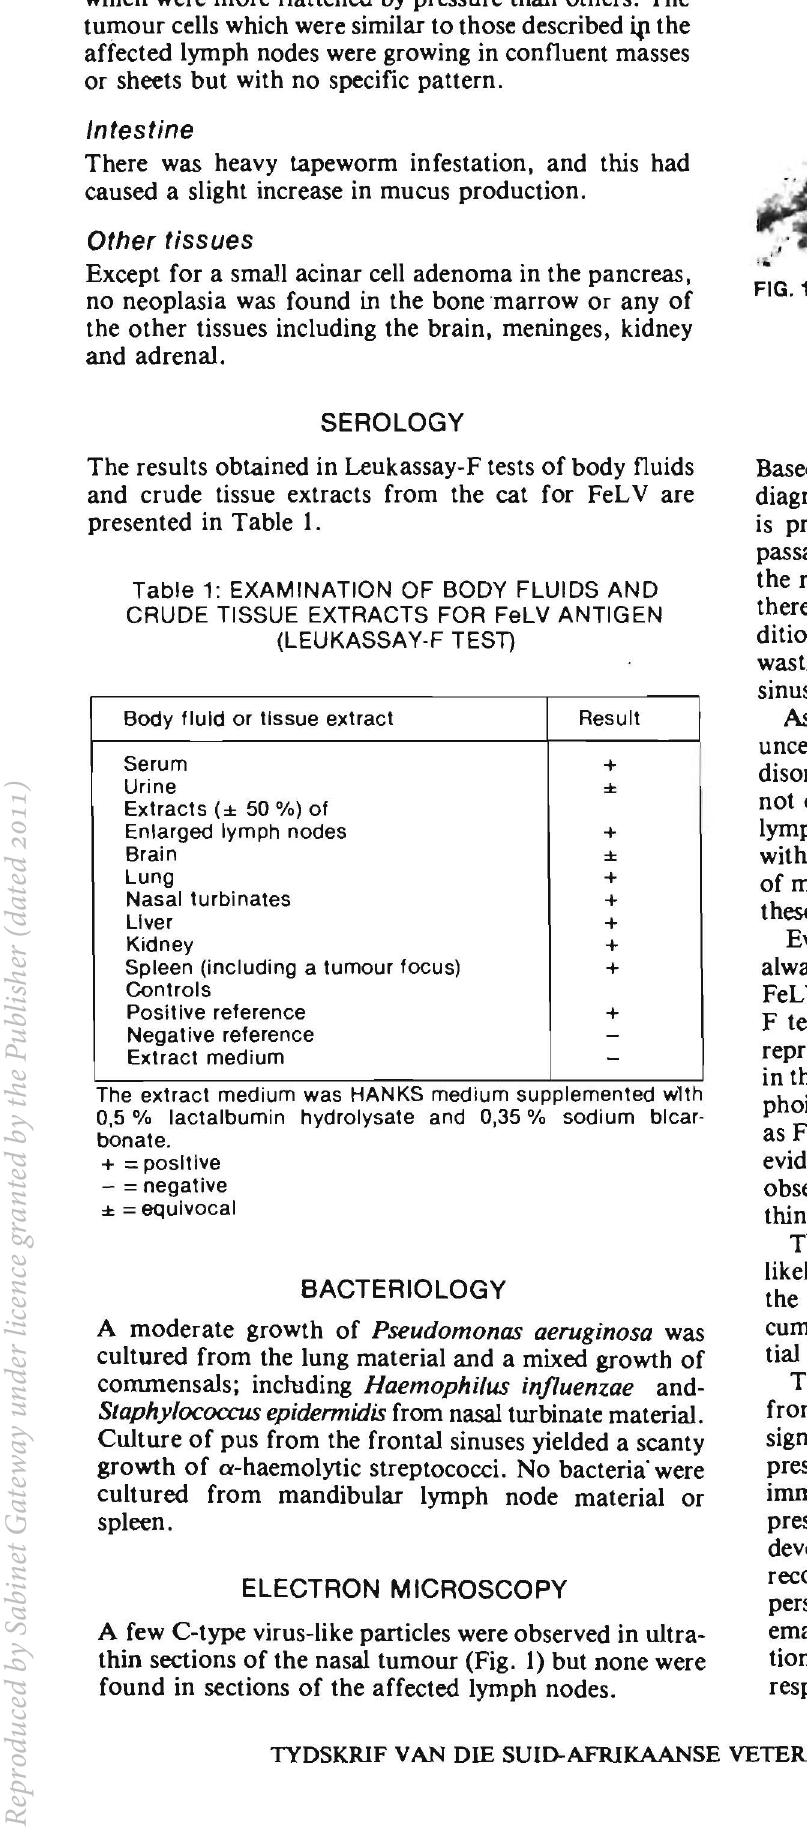
FIG.1: C-type virus-like particle (arrow) In ultra-thin section of the nasal tumour. The scale bar represents 100